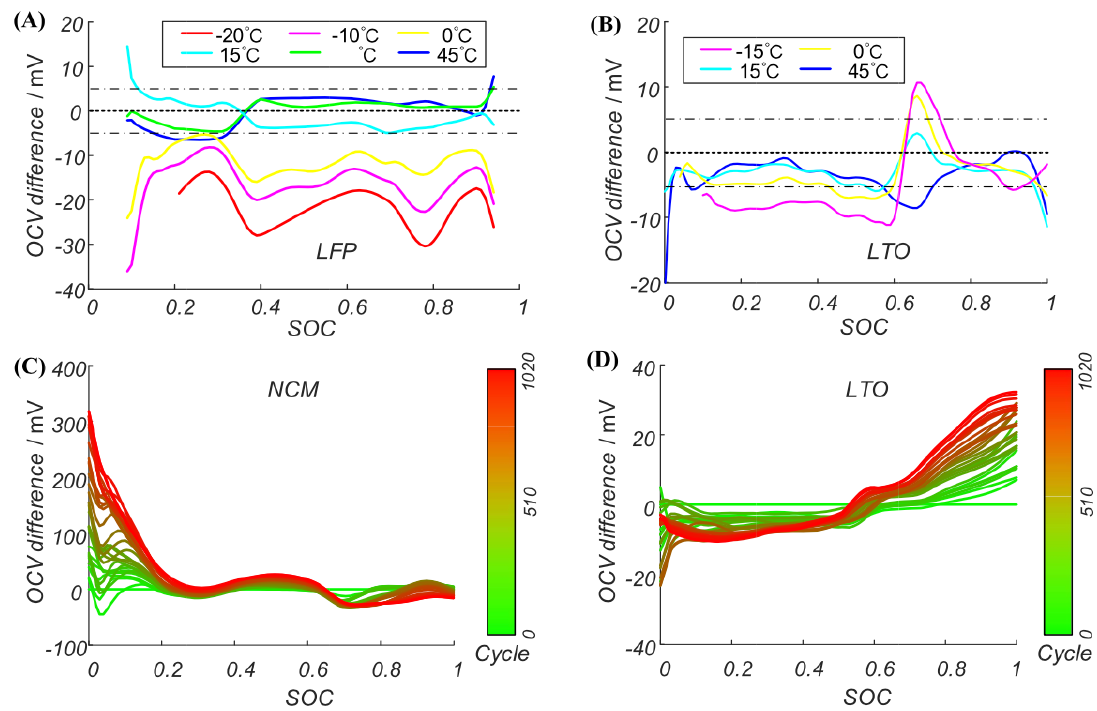
Figure 13. OCV characteristics under different temperatures and ageing at different SOCs. ( A ) LFP cell; ( B ) LTO cell; ( C ) NCM cell; ( D ) LTO cell [83].